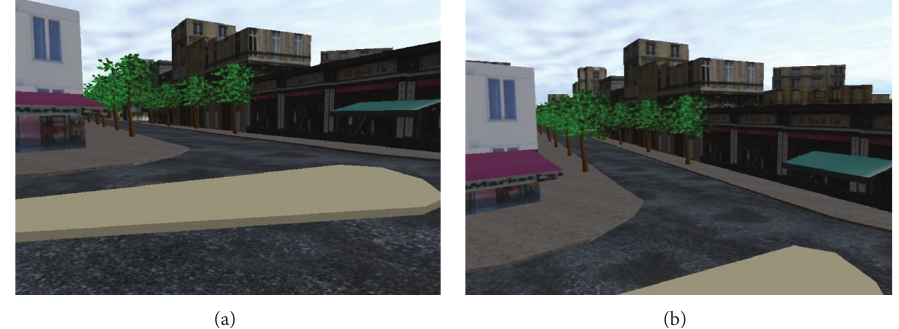
Figure 1: Pictures of the same spot in virtual environment, from the ground-level condition (a) and from the aerial-level condition